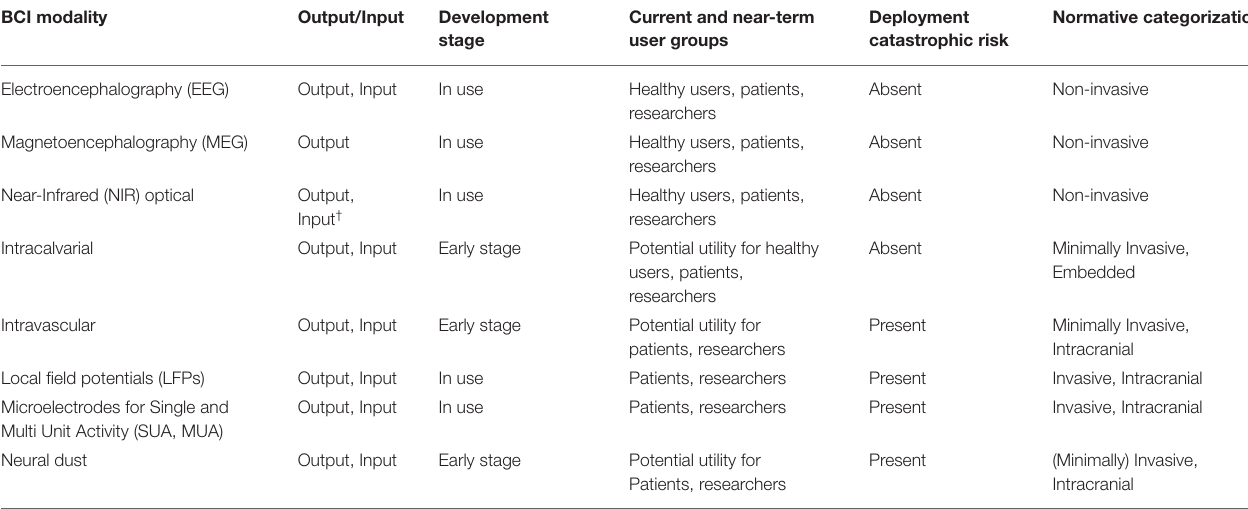
TABLE 1 | Representative current and emerging BCI